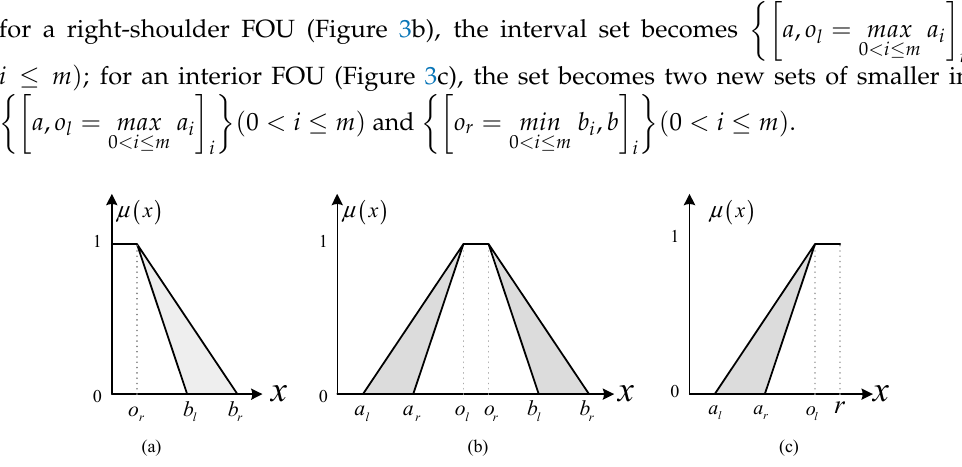
Figure 3. Three types of FOUs and their parameters: ( a ) left-shoulder FOU; ( b ) interior FOU; and ( c ) right-shoulder FOU, adapted from [42].